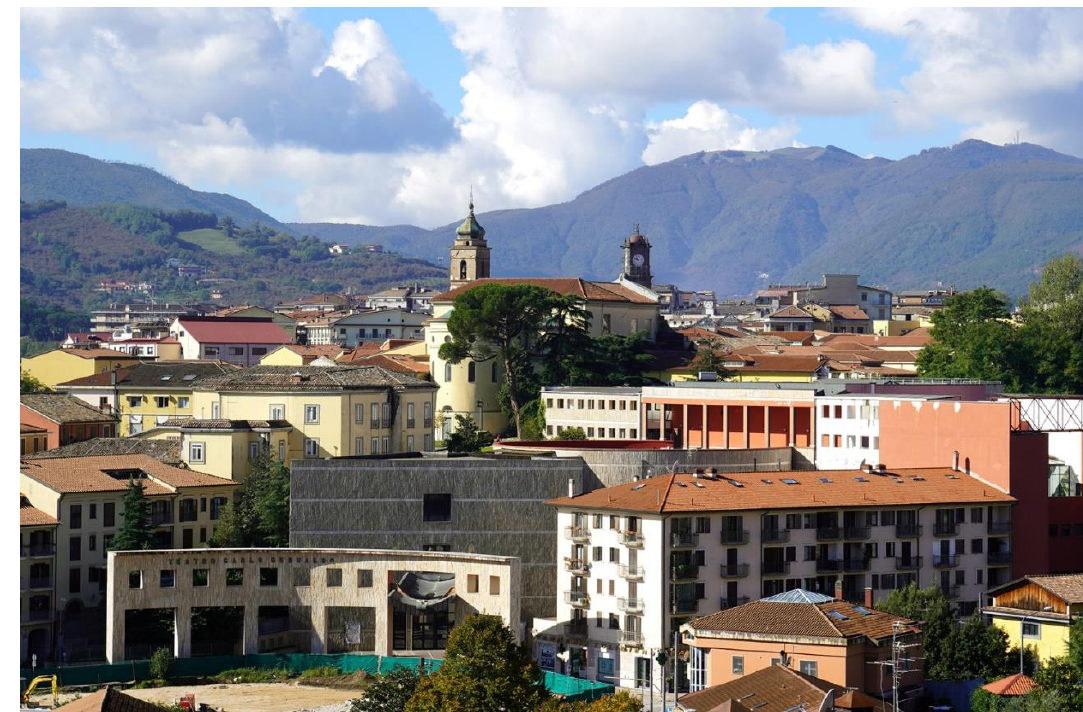
Figure 115. Avellino: panoramic view of the town (photos by [35,36]).